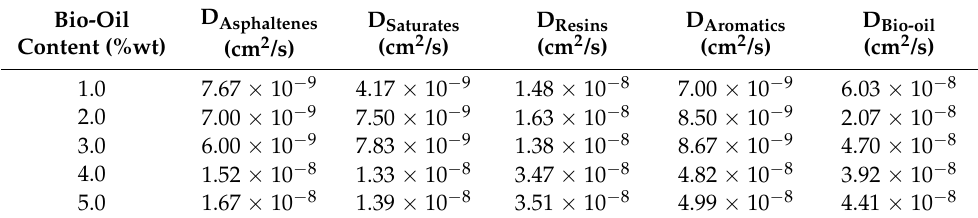
Table 5. Diffusion coefficients of the BRAA components.